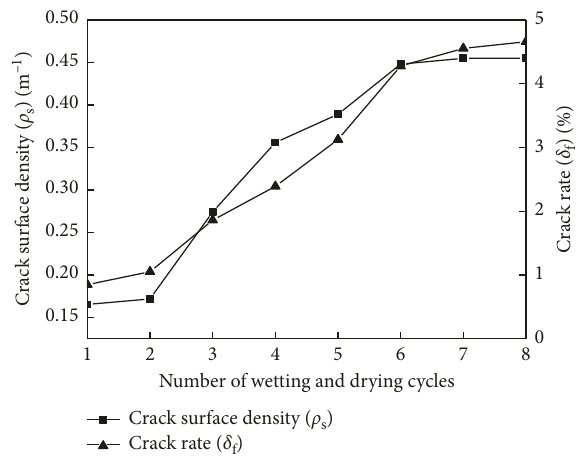
Figure 10: Curves of crack surface density and crack rate.